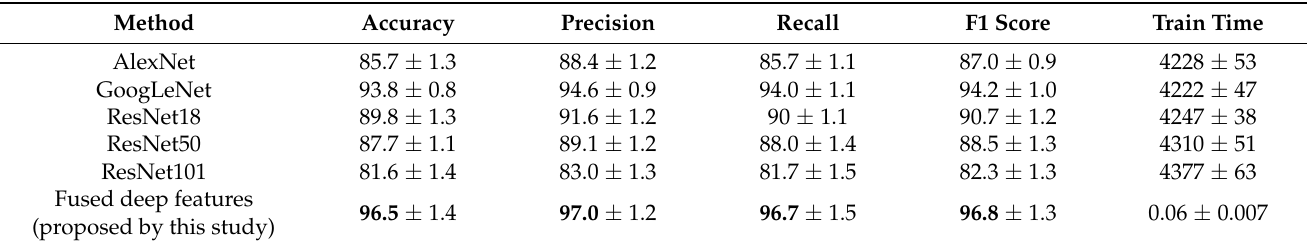
Table 7. Performance comparison between the proposed method and using CNN directly (bold font shows the best